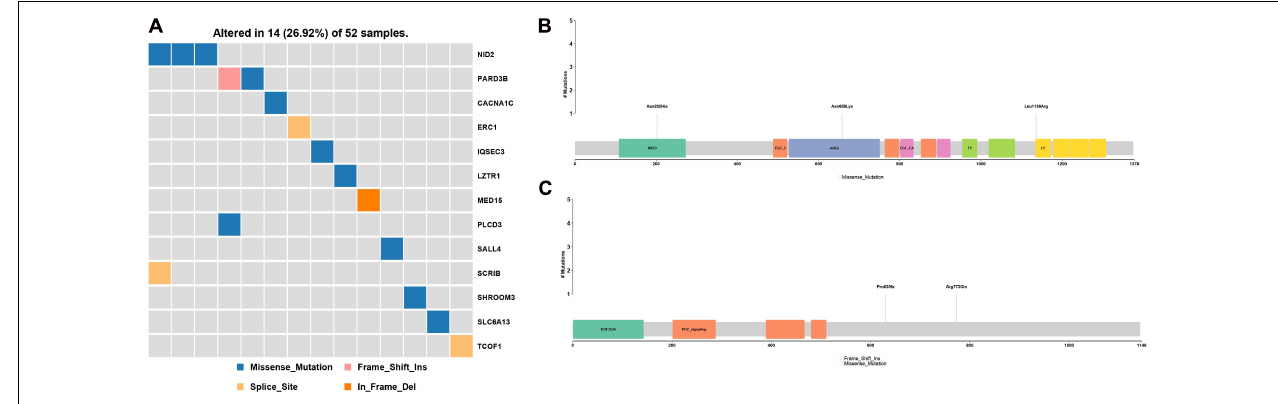
FIGURE 2 | Gene mutations identified among the analyzed hemifacial microsomia (HFM) patient cohort. (A) A total of 13 known HFM genes were found to be mutated in the studied patient cohort, affecting 14 (16.92%) of the 52 analyzed patients. These included (B) three NID2 mutations, Asn202His, Asn658Lys, and Leu1136Arg, and (C) two PARD3B mutations, Pro630fs and Arg773Gln.